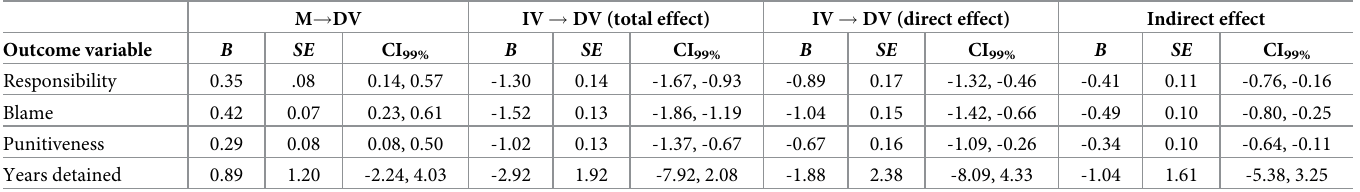
Table 2. Mediation model statistics: Effects of defense of mental impairment on crime judgments via agency (Study 1).